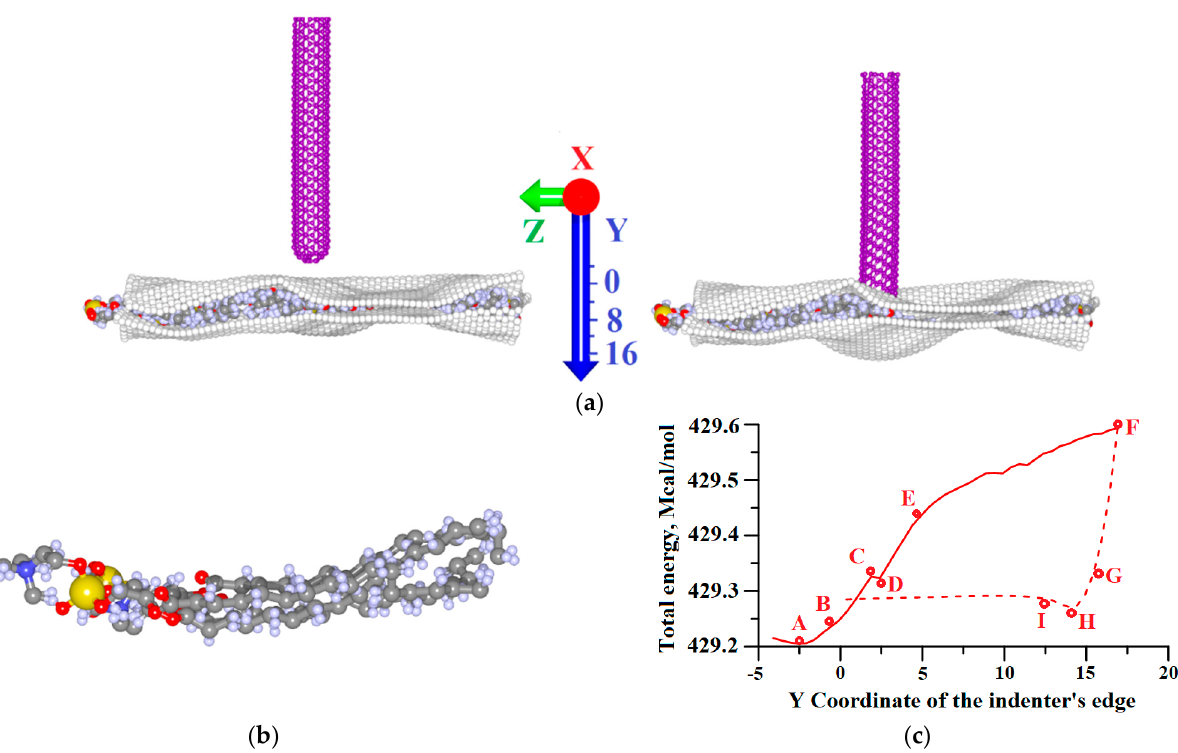
Figure 2. Nanoindentation of the composite graphene/DPPC by the carbon nanotube (CNT) with a closed edge: ( a ) initial (left) and last (right) point of indentation F; ( b ) the atomic structure of the central DPPC molecule at point F; and ( c ) the dependence of the system’s total energy on the CNT shift. The solid line corresponds to the forward stroke (FS) and the dotted line corresponds to the reverse. At the initial point, the edge of the CNT had the coordinate Y = 0, and the atoms of the upper graphene layer had the coordinate Y = − 4.1 Å. Table 1. Key points of the nanoindentation with corresponding Y coordinates; the values of the adhesion energy between bilayer graphene and dipalmitoylphosphatidylcholine (DPPC) molecules and maximum local stresses (MLSs) in these points. The abbreviation FS corresponds to forward stroke and RS corresponds to reverse stroke.